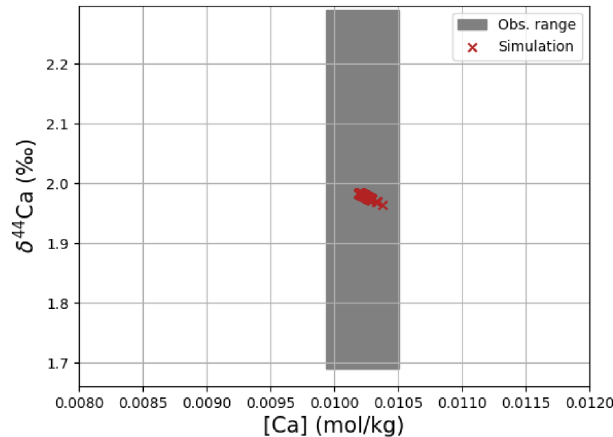
Figure 6. Comparison between measured and simulated concen- trations and isotopic composition of dissolved Ca in seawater. The gray box indicates the range of concentrations and isotopic com- positions that were measured on separate samples (Fabricand et al., 1967; De Villiers, 1999; Fantle and Tipper, 2014). Observations and model results are